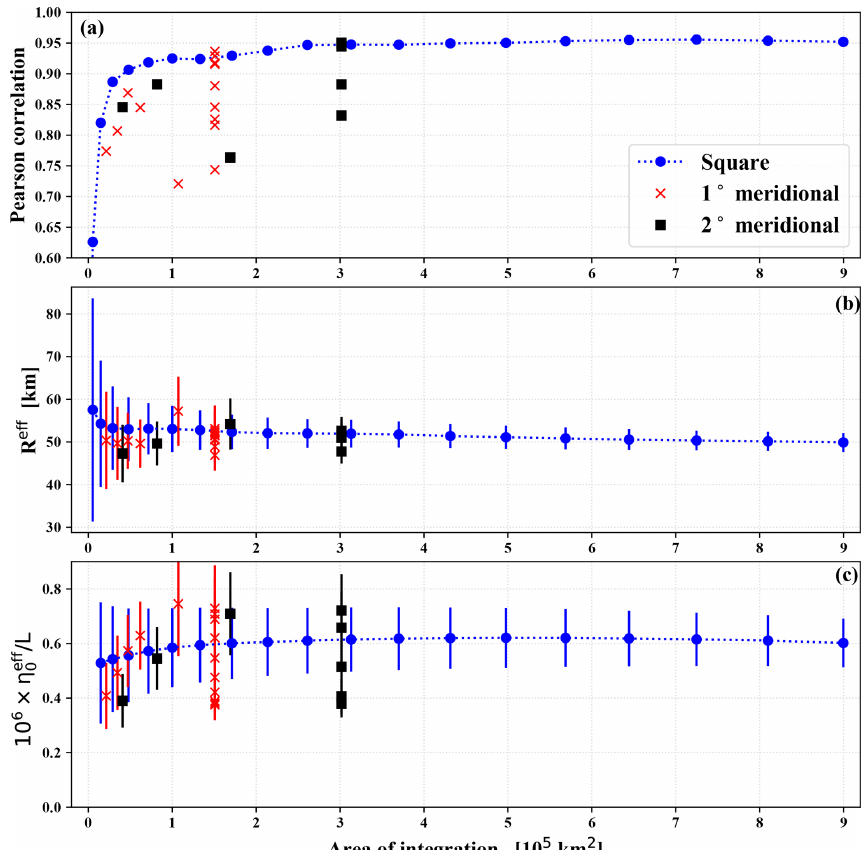
Figure 5. (a) Pearson correlation coefficient for the total kinetic energy and enstrophy as a function of the area of integration. Blue circles indicate growing correlations for square-shaped areas around a central grid cell in the offshore region (40.125 ◦ N, 130.125 ◦ W); see Fig. 4. Red crosses (black squares) denote correlation coefficients for meridional stripes of width of 1 ◦ (2 ◦ ) longitude. (b) Fitted mean scale param- eter R eff for a super-vortex determined from the ratio of integrated kinetic energy and enstrophy (in kilometers). Notations are the same as in panel (a) . (c) Fitted mean height parameter η eff normalized by the square root of the area of integration L (and rescaled for the sake of 0 convenience) for a super-vortex determined from the integrated kinetic energy; see Eq. (4). Notations are the same as in panel (a)